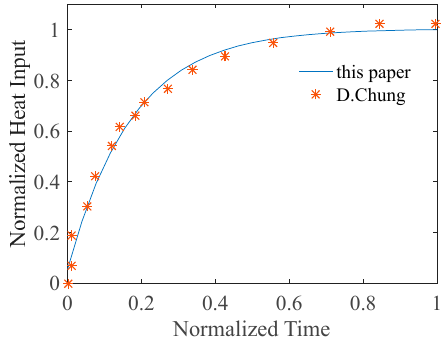
Figure 5. Normalized heat input on the inner wall of the gun barrel with normalized time.